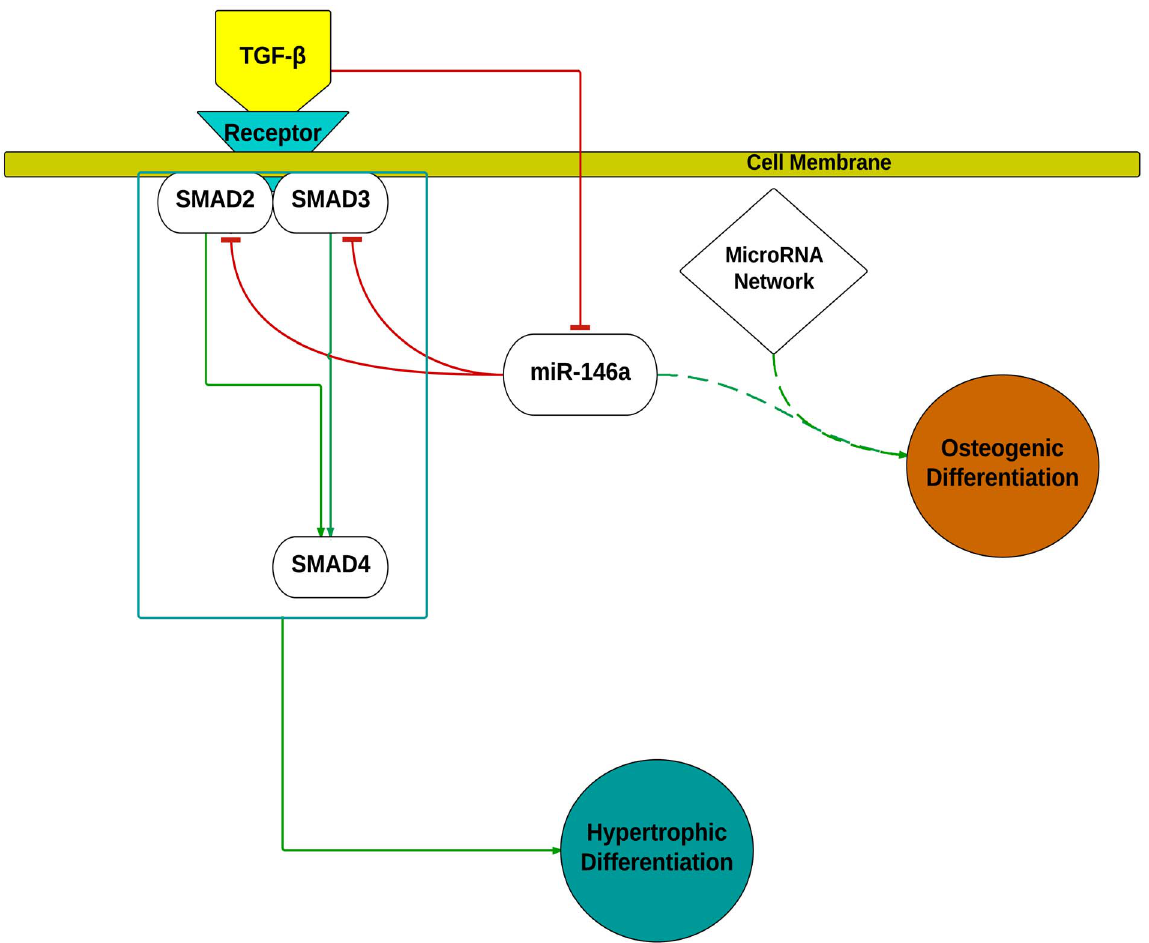
Figure 9. Modulation of skeletal cell differentiation by miR-146a. miR-146a down-regulated SMAD2 and SMAD3 protein levels, resulting in an attenuation of TGF- b signaling following TGF- b 3 stimulation. Stimulation by TGF- b 3 down-regulated the expression of miR-146a indicating a double negative feedback loop and thus a potential auto-regulatory mechanism. Overexpression of miR-146a under basal condition revealed a modest, but positive effect on osteogenesis related gene expression and is likely part of a miR network involved in promoting osteogenesis. The inhibitory effect of miR-146a on SMAD4 was previously reported by Zhong et al [31] and was not reevaluated in this study.